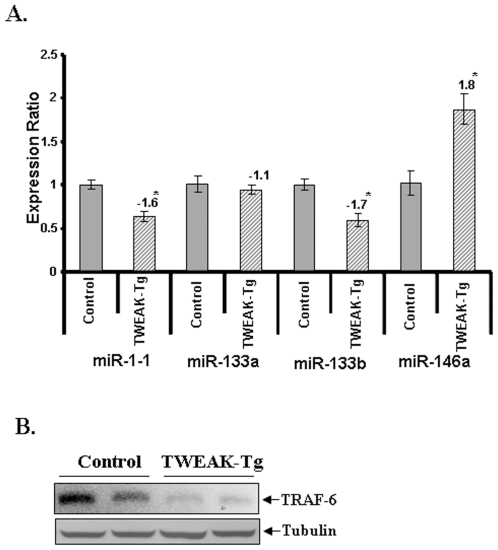
Expression profiles of select microRNAs and TRAF-6 proteins in skeletal muscle of TWEAK-Tg mice.
A) TaqMan QRT-PCR analysis of miR-1-1, miR-133a, miR-133b, and miR-146a in skeletal muscles of TWEAK-Tg mice. Gastrocnemius muscle from 6 months old TWEAK-Tg mice and littermate control mice were taken and total RNA enriched with small RNAs was isolated for TaqMan qRT-PCR analysis. The normalized expression ratios were plotted for each miRNA are mean ± SD (n = 3). ‘*’ represents the statistical significance (p-value ≤0.01). B). Gastrocnemius muscle of 6 months old TWEAK-Tg mice and littermate control mice were taken and total protein was isolated for Western blotting analysis. Representative immunoblot presented here show that the levels of TRAF-6 are considerably reduced in skeletal muscle of TWEAK-Tg (n = 4) mice compared to control (n = 4) mice. Equal amounts of protein loading were ensured by the expression levels of β-actin.